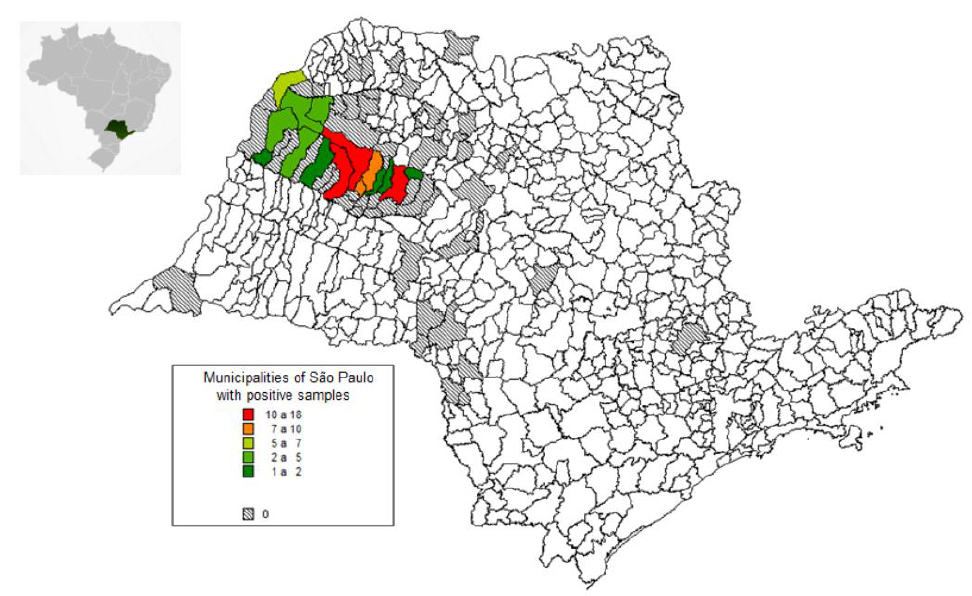
Figure 1. Maps of Brazil and the state of São Paulo showing the origin of the bat samples sent for rabies diagnosis from 1998 to 2017 (gray) and the cities with positive samples (colors).